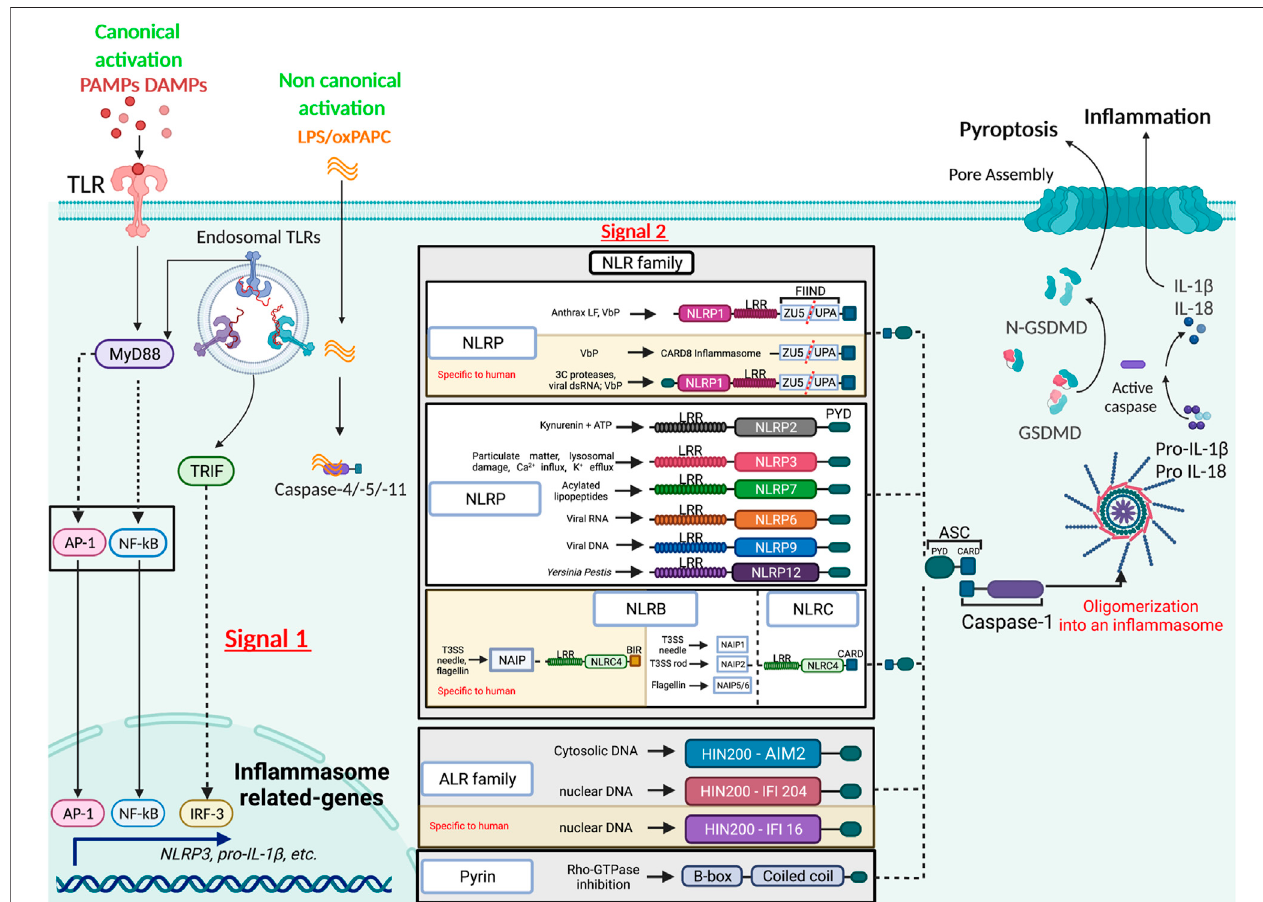
FIGURE 1 | Diverse mechanisms of in fl ammasome activation. The activation of the in fl ammasome by the canonical pathway relies on two signals, the fi rst or the priming signal allowing transcription of in fl ammasome components, and the second or activating signal triggering the assembly of the complex. The in fl ammasome scaffoldingreceptors belongtodifferentfamilies(NLR,ALRandPYRIN),eachrecognizingdifferentMAMPsorDAMPs. Caspase-1iscentralincatalyzingin fl ammasome functions, cleaving pro-in fl ammatory cytokines into their bioactive form and gasdermin D (GSDMD) into an N-terminal pore forming domain that elicits pyroptosis. The non-canonical route is mediated by direct binding of LPS or phospholipids to caspase-4/-5 in humans or -11 in mice.